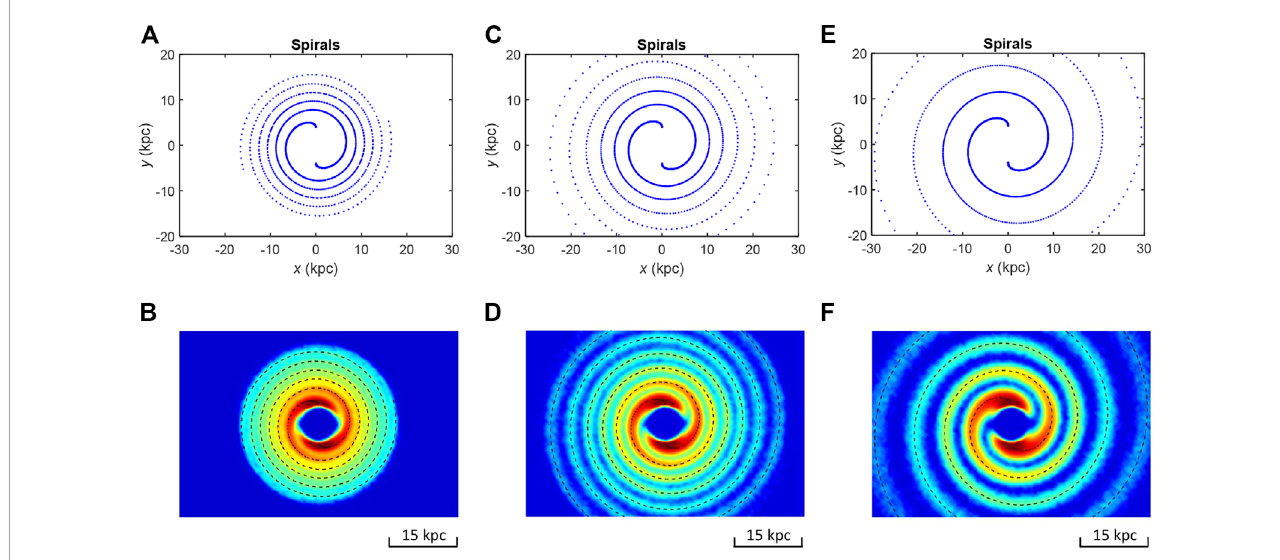
FIGURE 6 Geometry of spirals: dependence on the galaxy age. The critical radius R c and the rotation velocity V ϕ are 4 kpc and 217.7 km/s. The upper/lower plots show orbits with unperturbed/perturbed parameters R c and ϕ . The galaxy age and the maximum redshift are 8.0 Gyr and z = 3 . 20 in (A, B) , 8.5 Gyr and z = 5 . 65 in (C, D) , and 8.8 Gyr and z = 11 . 18 in (E, F) . The masses of the bulge and disk are M b = 8.5 × 10 9 M ⊙ and M d = 8.5 × 10 10 M ⊙ , respectively.